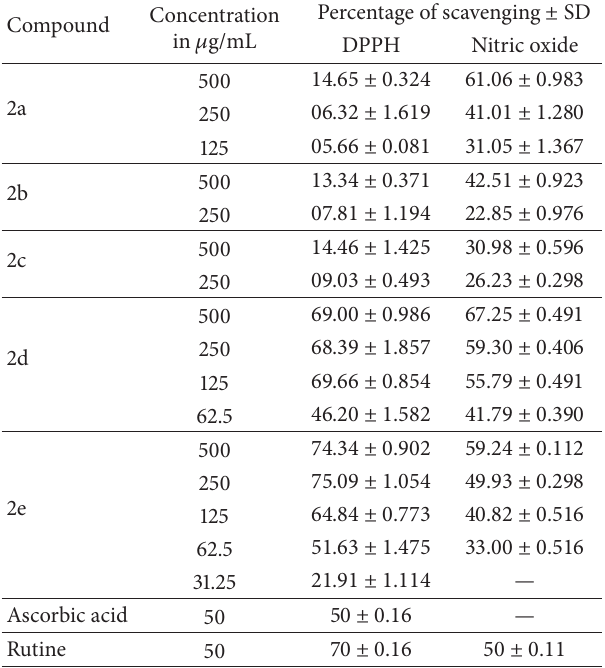
Table 3: Free radical scavenging activity of 5-furan-2-yl-3-aryl-4,